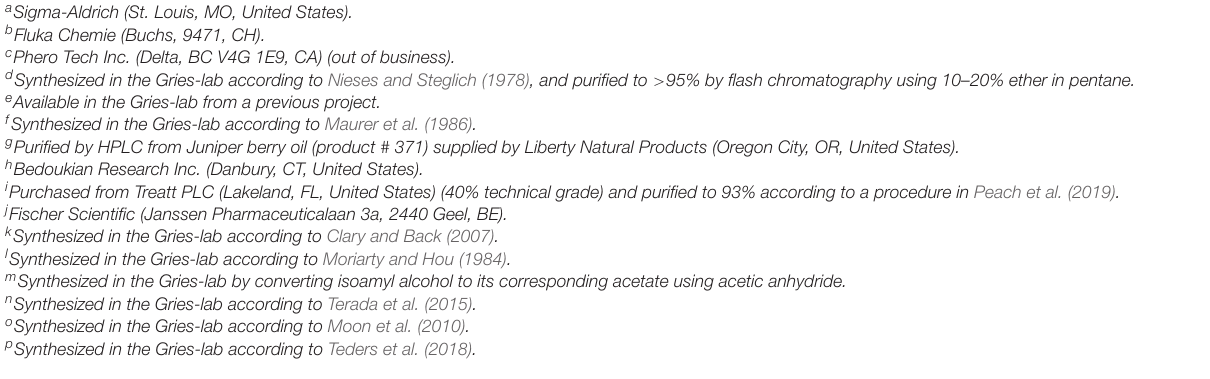
Drawing on results that 0.5 g of bird excreta attracted ants in 10-min bioassays (see Section “Results” in Exp. 8), we tested headspace volatile extract in experiment 12 at 0.084